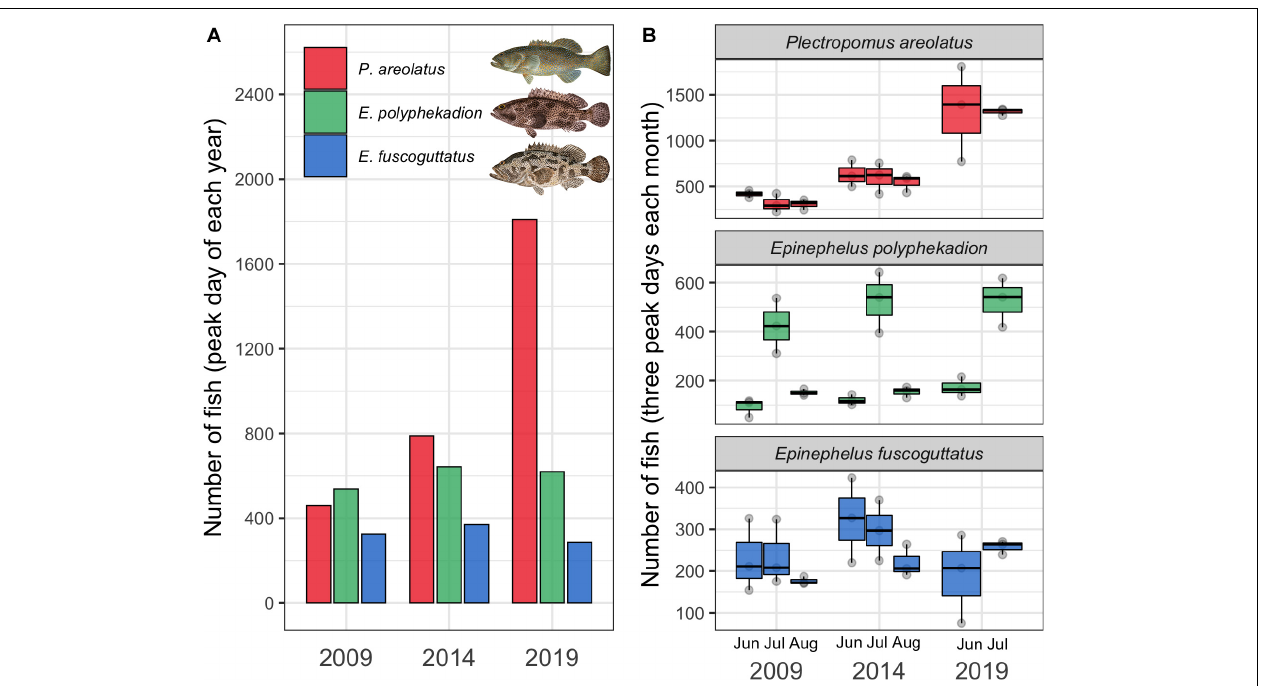
FIGURE 2 | (A) Annual peak number (abundance) of fish recorded on daily surveys conducted during 2009, 2014 and 2019 for P. areolatus (red), E. polyphekadion (green), and E. fuscoguttatus (blue) at the Ebiil channel aggregation site. (B) Fish abundance from the three highest daily counts during the peak months (June, July, and August) of 2009, 2014, and 2019. Fish illustrations by Les Hata